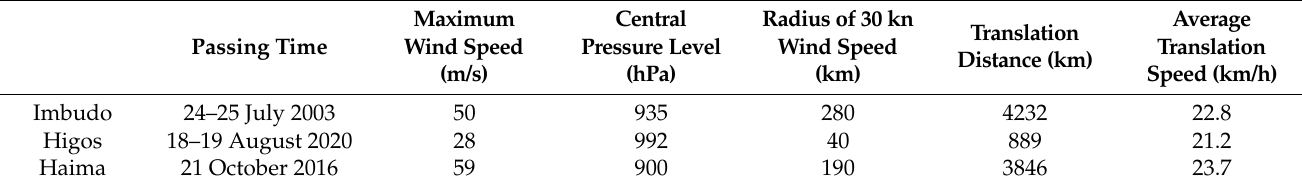
Table 3. The basic information of three selected typhoons.